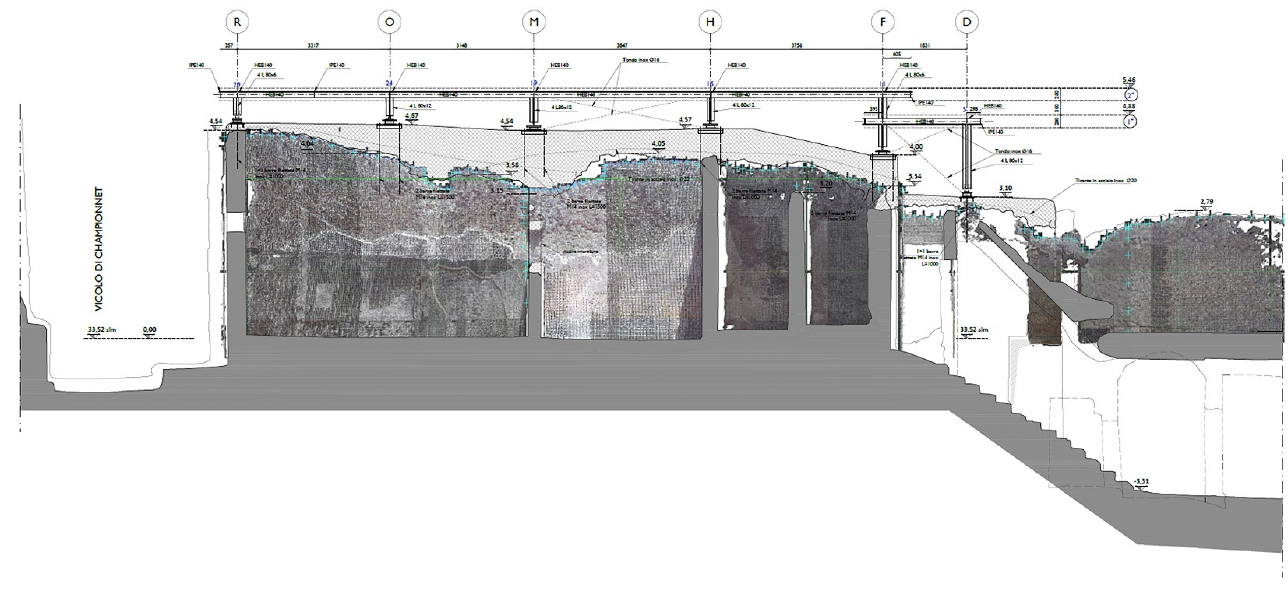
Figure 12. Executive section with cover, supports, and walls.